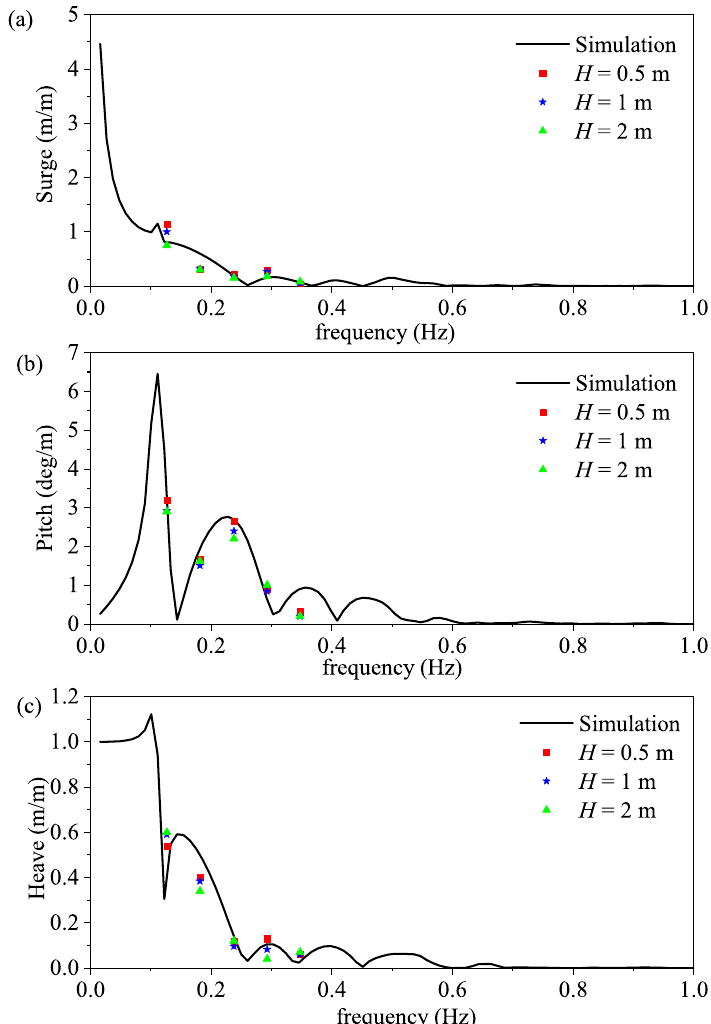
Figure 10. RAOs for ( a ) surge motion; ( b ) pitch motion; ( c ) heave motion. However, the simulation results of pitch motion in the high-frequency range (e.g., 0.182 Hz) are overestimated. The reason for this observation is the wave attenuation that is caused by standing waves, as shown in Figure 11. To distinguish the results more clearly, two dotted circles are drawn to mark the standing waves. The wavelength in the current sea state is greater than the diameter of the sphere node but less than the over-length of the BDFF. Therefore, it can be observed that, in the high-frequency condition, the transmitted waves and the reflected waves meet and collide; then, the standing waves appear between internal cavities formed by the distributed floaters. On the contrary, for long-period waves, the waves can easily propagate through the BDFF, which mitigates the interaction effect between waves and